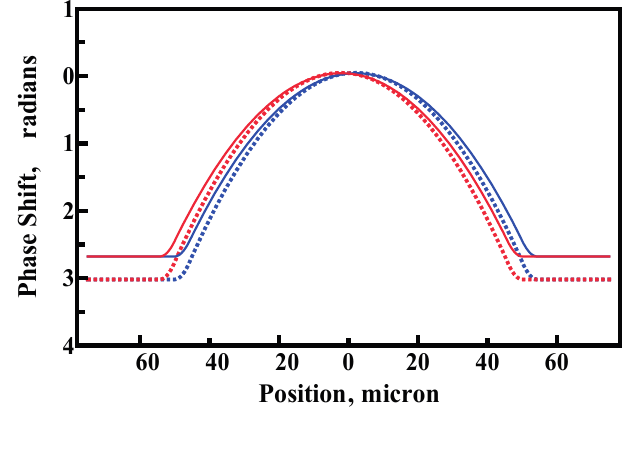
Figure 4. The simulated phase shift at the oblique angle. The dotted line represents the phase shift of o-mode and the solid line represents the phase shift of e-mode. The blue and red represent the incident angle θ i is +15.7° and − 15.7°,